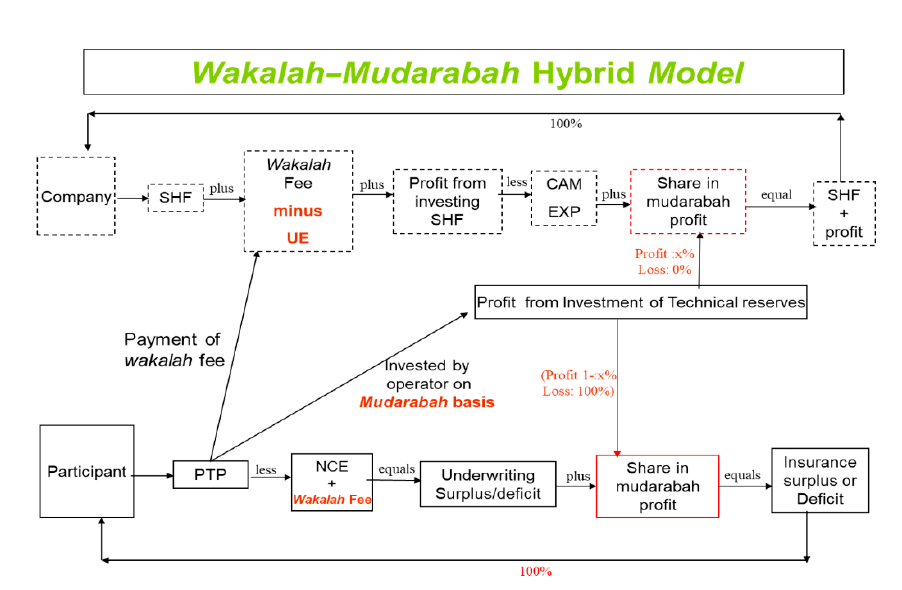
Figure 4. Wakalah – Mudarabah hybrid operational model of takaful.